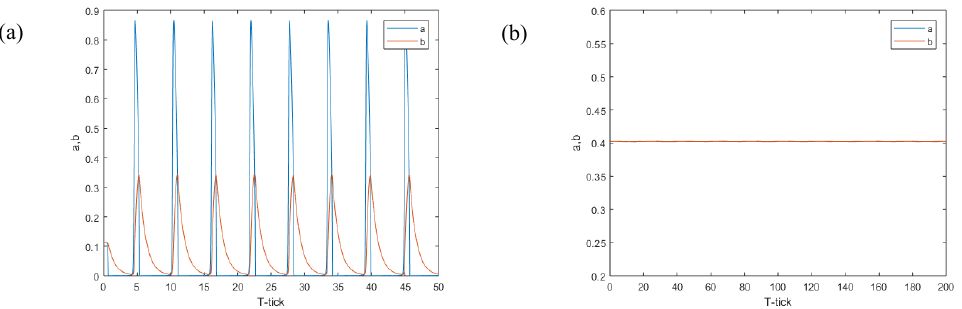
Figure 2. ( a ) Numerical simulation when f = 0.9 ε = 0.04 q = 0.0008, the initial value at the equilibrium point. The concentrations of ingredients oscillate periodically and do not stabilize at the equilibrium point, and the oscillations are not symmetric about the equilibrium point. ( b ) Numerical simulation when f = 0.6, ε = 0.6, q = 0.0008, the initial value at the equilibrium point. The concentrations of ingredients remain the same, and the relationship with time is a straight line, indicating that this is a stable state of the reaction.